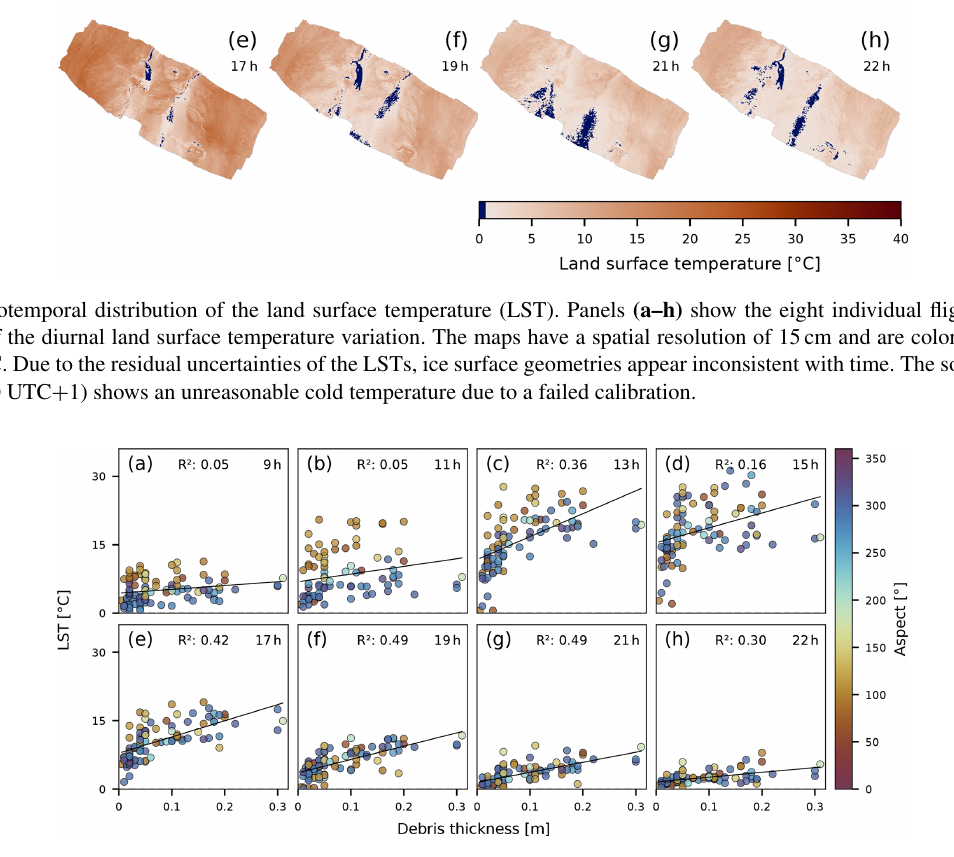
Figure 4. The temporal variation of the land surface temperature (LST) against in situ-measured debris thickness. Panels (a–h) show the arithmetic mean land surface temperature of a 2m buffered region around the GPS coordinates of debris-thickness measurements colorized for terrain aspect with 0 / 360 ◦ facing north. The LST of the warming phases (a–d) is more strongly influenced by the aspect than the cooling phases (e–h) . The non-linear nature of the relationship between the LST and debris thickness is noticeably pronounced for higher LSTs (c–e) , while the correlation for low LSTs appears more linear (f–h)